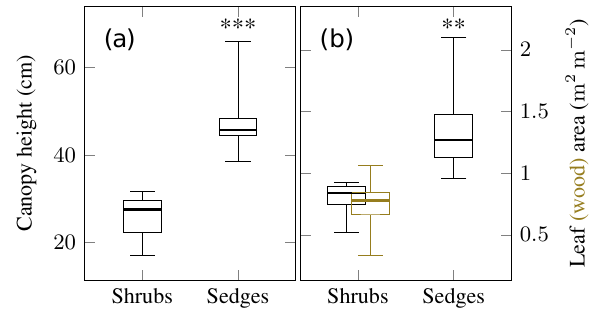
Figure 3. (a) Spatial variability of canopy height and (b) green leaf and wood area index measured 28–30 July 2013, percentiles (25, 50, and 75), minimum and maximum values of eight plots per vegetation type; please note that the wet sedges canopy addition- ally comprises standing dead leaves with an area of about 1.1 times green leaf area; significant differences between vegetation types are shown with ∗∗ ( p ≤ 0.01) and ∗∗∗ ( p ≤